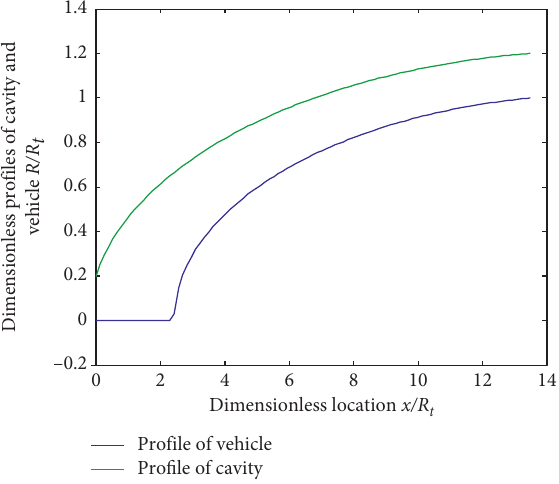
Figure 11: Profile of conical section for ventilated SVs. Table 2: Parameters in water tunnel